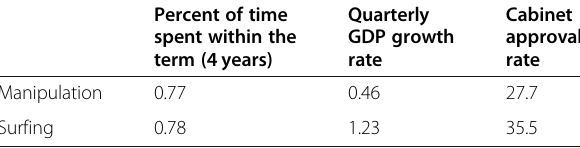
Table 5 Average Indicator Values for Each Group with Threshold k 1 = k 2 =